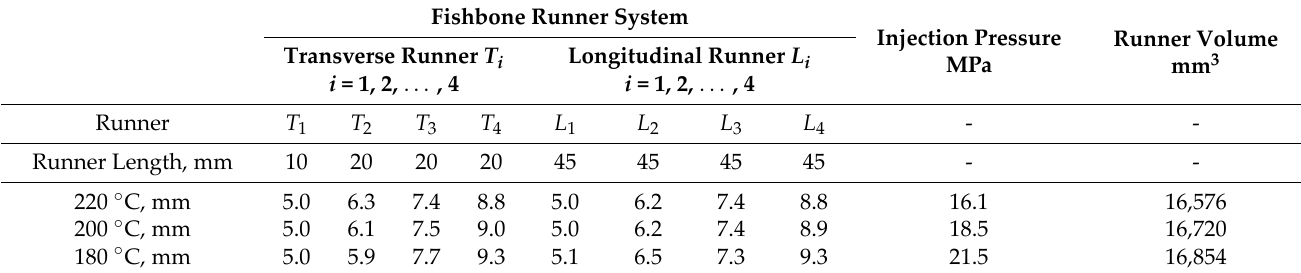
Table 3. Optimal diameters of the runner system and injection pressure at different melt temperature.